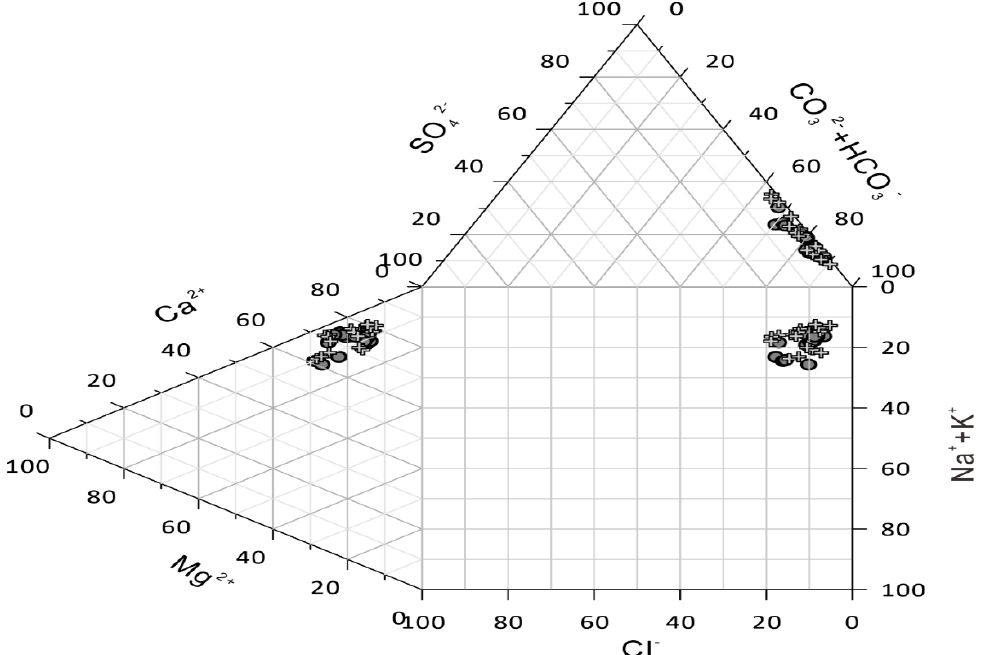
Figure 2. Durov diagram for the water samples from the Issyk − Kul Basin. The grey dots correspond to the samples during the period with low river flow (L, n = 19 ) and the black crosses correspond to the period with high river flow (H, n = 19 ).